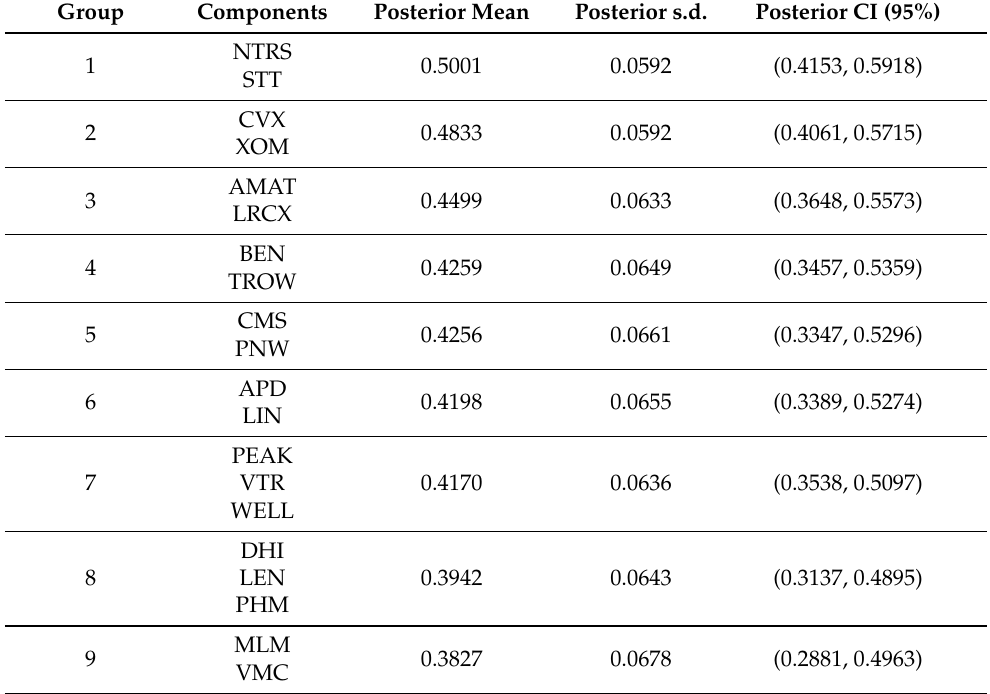
Table 4. Posterior distributions for lower tail